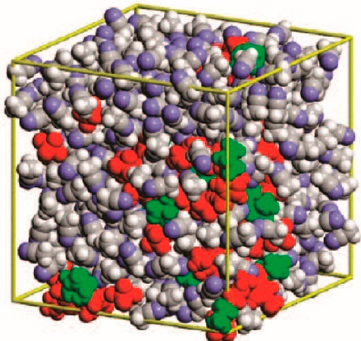
Figure 1. Mixture of acetonitrile with 20% (v / v) BMImPF 6 . Red: BMIm + , Green: PF 6 − , Blue / white: acetonitrile. Adapted with permission from Acc. Chem. Res. (2007) 40, 1087–1096. Copyright 2007 American Chemical Society.